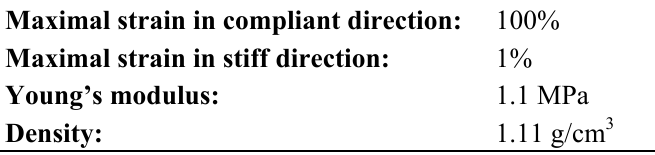
Table 1. Technical data of PolyPower. Notice PolyPower is only strainable in one direction. Strain in the stiff direction will damage the